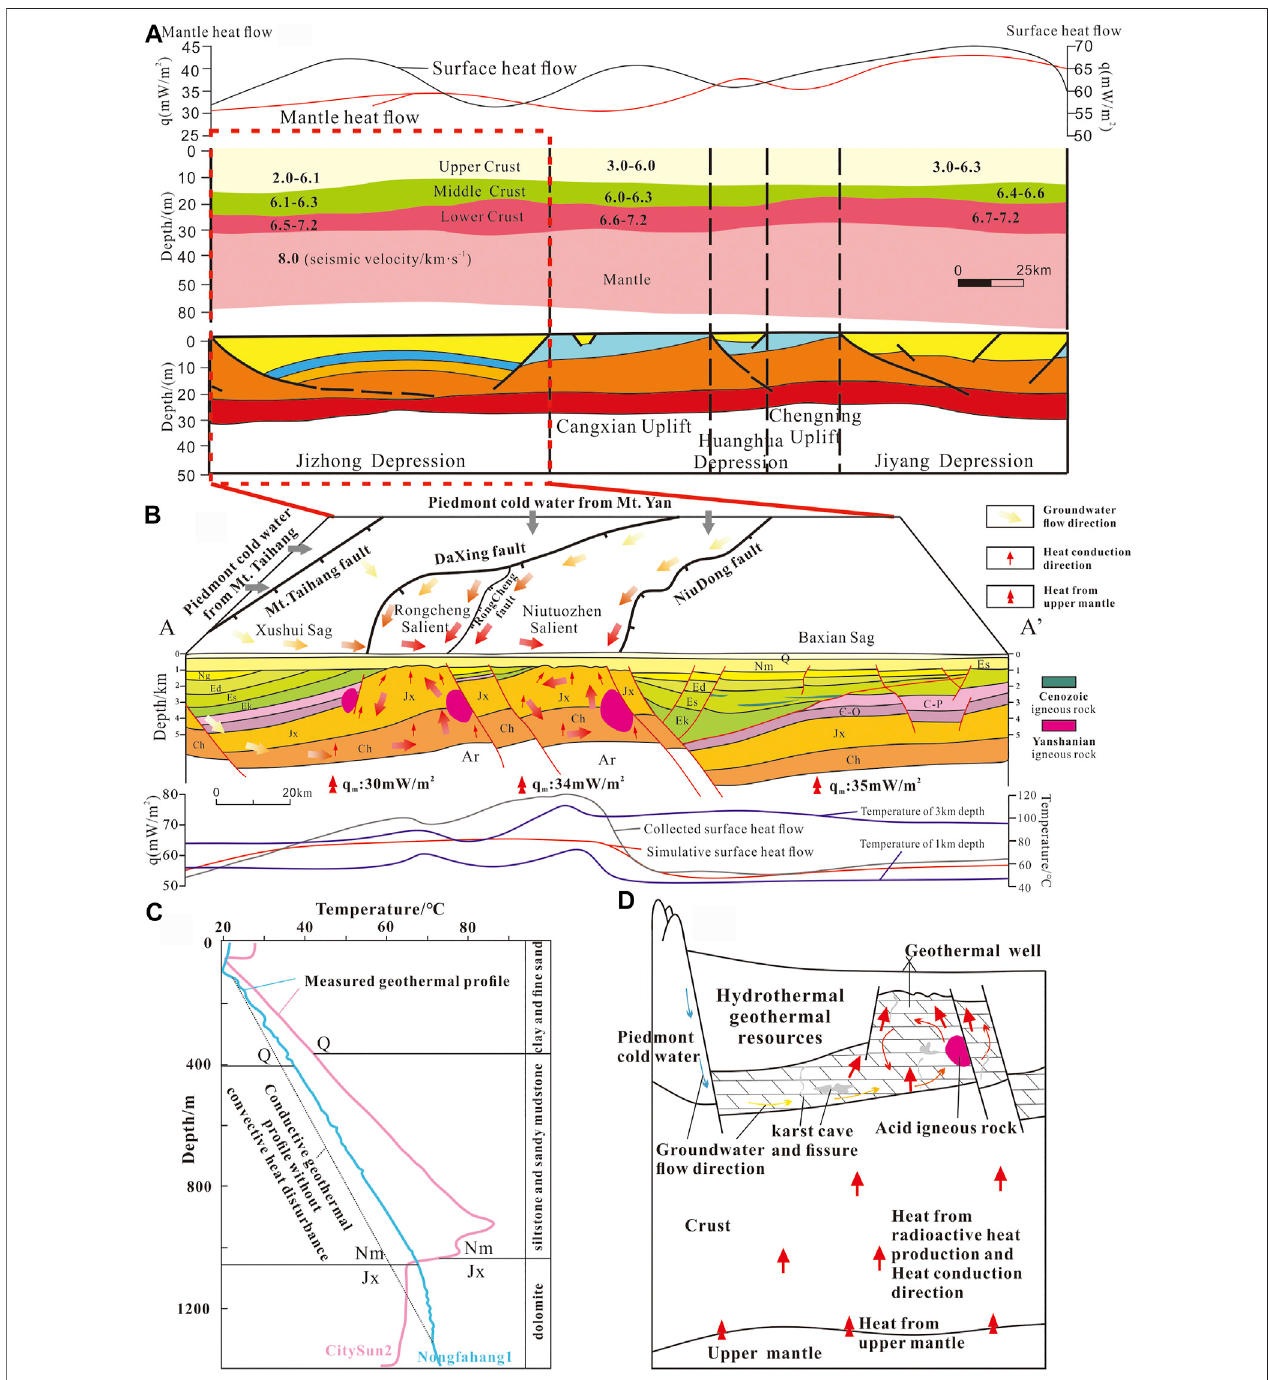
FIGURE 12 | Aggregative model of the heat source genesis in Xiong ’ an new area. (A) Crust mantle velocity structure and mantle terrestrial heat fl ow through Jizhong depression after Ma et al. (1991) and Xu (2017); (B) Genesis of conduction-convection geothermal resources of AA ′ section in Jizhong depression; (C) Well temperature diagram affected by heat convection after by Wang et al. (2019); (D) Genetic model of geothermal resources in Xiong ’ an new area.